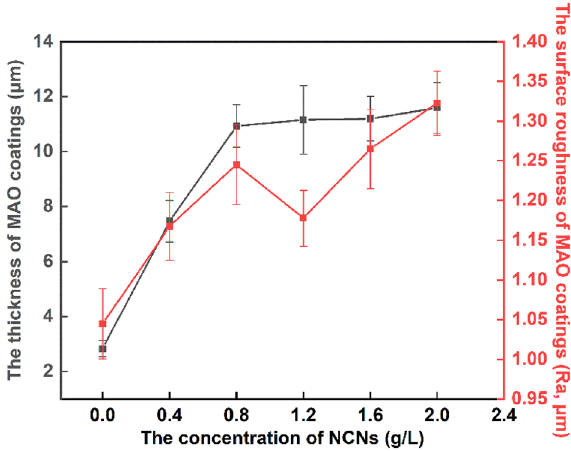
Figure 5. The thickness and surface roughness of the MAO coatings (OriginPro 2018, https:// www. origi nlab. com/ index. aspx? go= Produ cts/